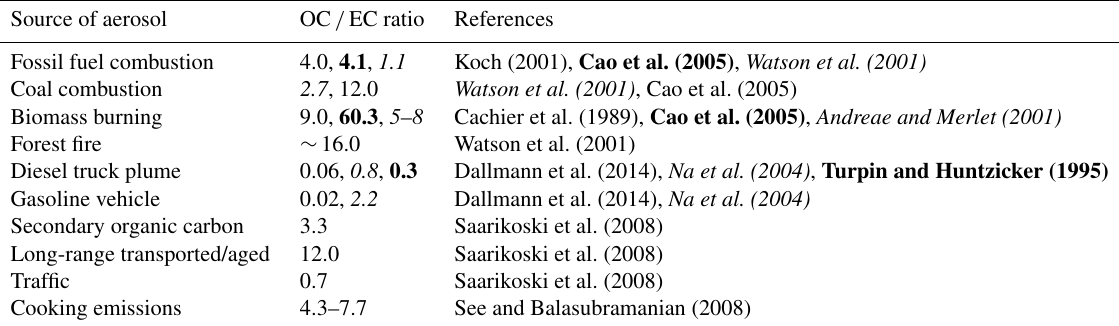
Table 2. Literature values of OC / EC ratios for various sources of aerosol. Different font styles indicate different OC / EC values from different